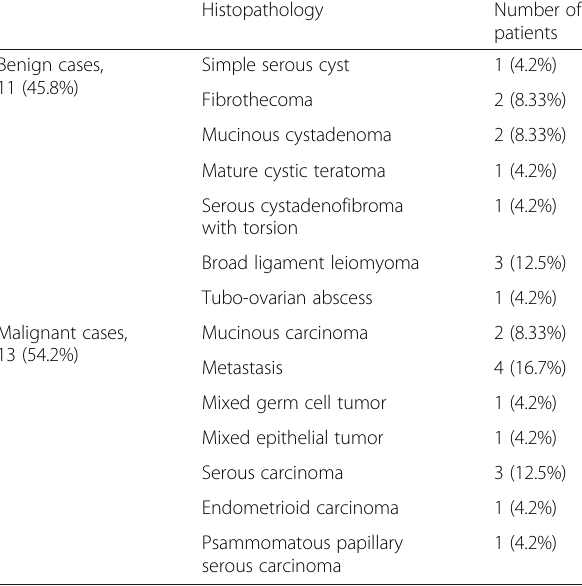
Table 1 Pathological entities of examined cases Histopathology